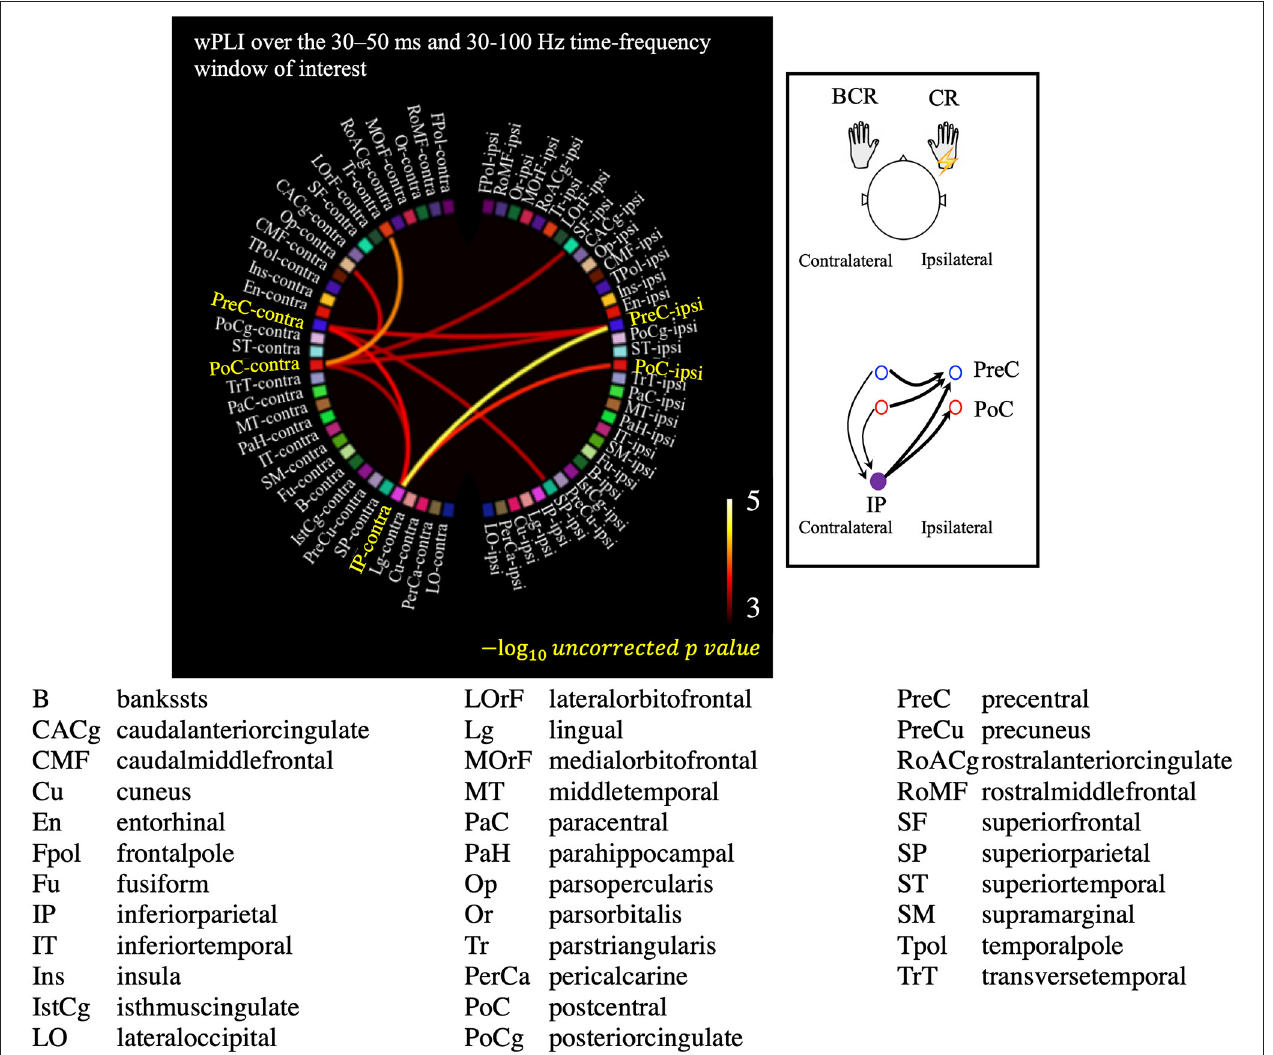
FIGURE 6 | Results of the all-to-all connectivity analysis visualized on a circular representation, showing only the connections involving the S1/M1 regions. Connectivity was measured using the averaged weighted phase-lag index value over the 30–50ms and 30–100Hz time-frequency window of interest. A negative 10-based logarithm of uncorrected p values (uncorrected p < 5 × 10 − 4 ) is indicated by the color bar. The schematic image of significant connections that contains each of PreC, PoC, and IP is shown in the